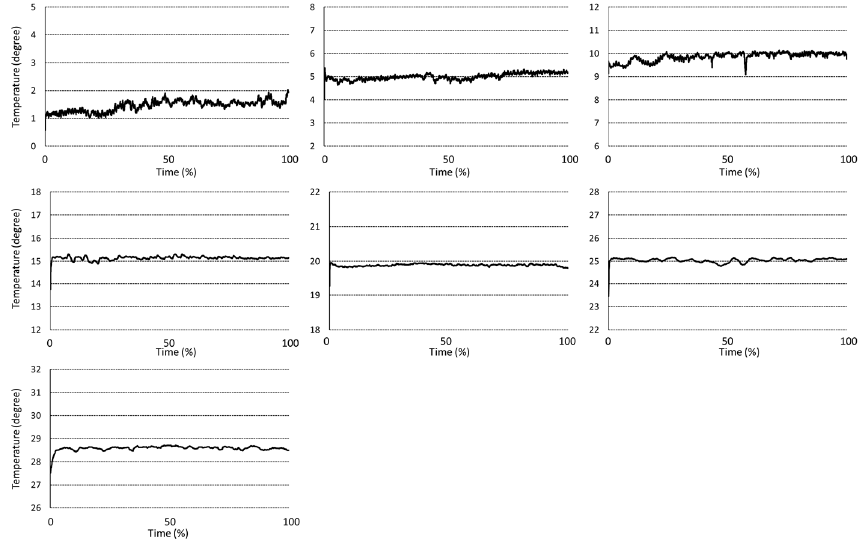
Figure 2. Static temperature condition for measurement of egg freshness during storage.